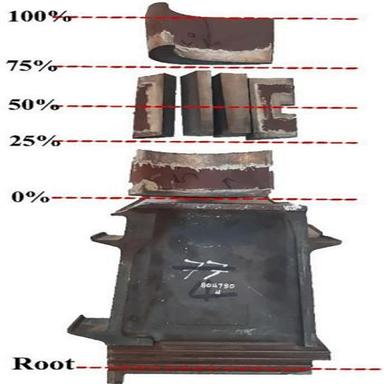
The Cutoff-plan of the exposed blade.